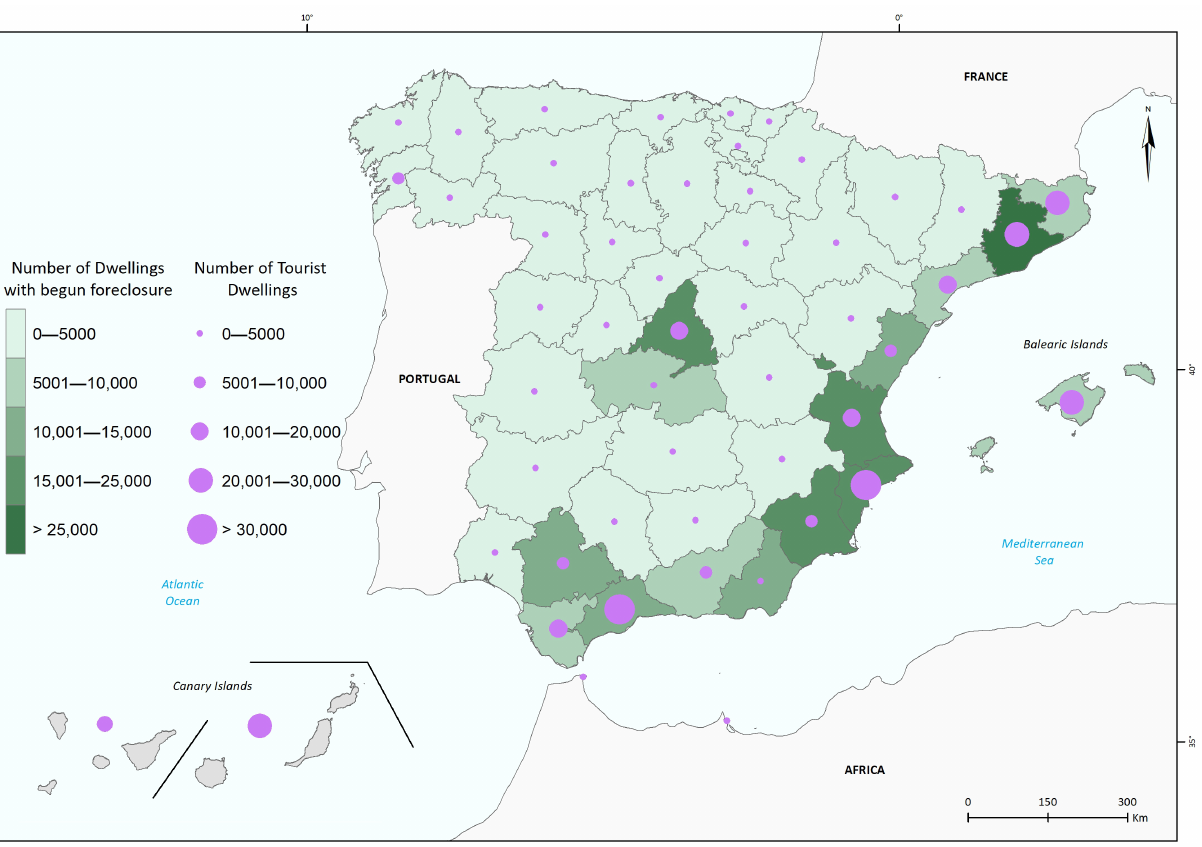
Figure 7. Tourist dwellings by province in absolute figures in 2020, and number of dwellings with foreclosure begun by province, 2014–2019. Source: Measurement of the Number of Tourist Dwellings by Province. National Statistics Institute (INE) [47], and Dwellings with Foreclosure Begun by Province. National Statistics Institute (INE) [48]. Author’s